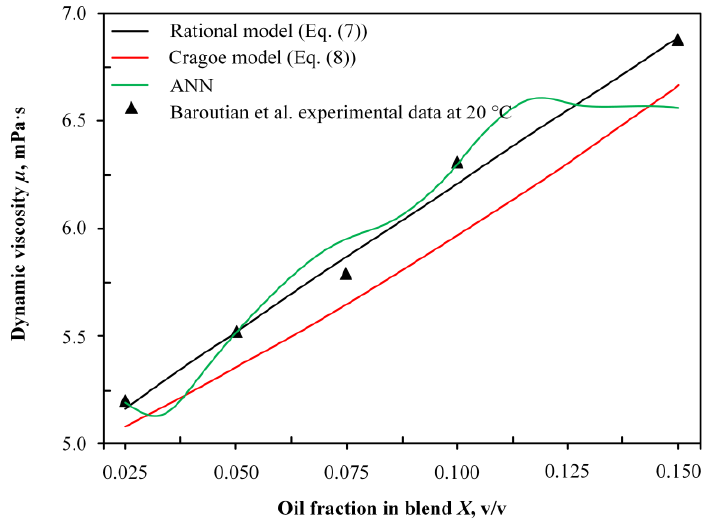
Fig. 8. Variation in dynamic viscosity vs. oil fraction at 20 °C (for equal oil and biodiesel content).